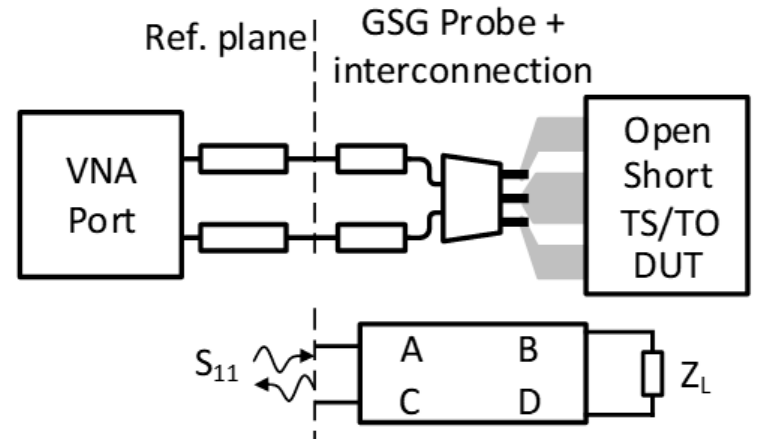
Figure A1. Schematic used for 1-port S 11 measurements with different loads: open, short, translated short (TS), translated open (TO), and device under test (DUT), as well as the corresponding network equivalent.